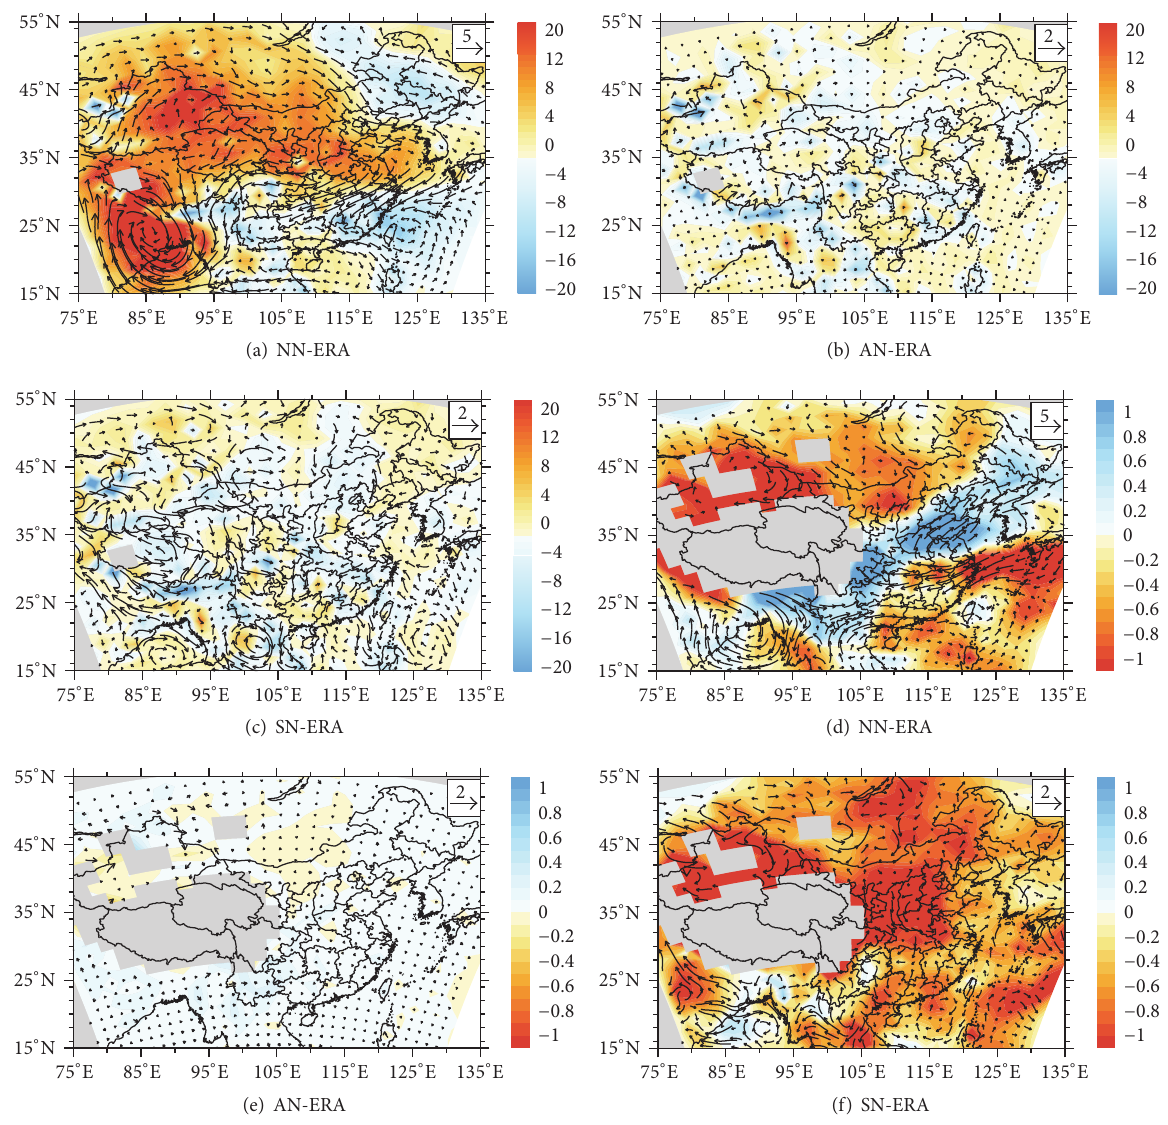
Figure 8: The model biases of monthly mean geopotential height (shading in units of meter) and horizontal winds (vector in units of 5 m/s withNN,but2 m/swithANandSN)at500hPa((a)–(c))andmonthlymeanwatervapormixingratio(shadinginunitsofq/kg)andhorizontal winds at 700 hPa ((d)–(f)) in June, 2011. Respectively, (a) and (d) are the biases simulated with the no nudging experiment (NN), (b) and (e) are the biases simulated with the analysis nudging experiment (AN), and (c) and (f) are the biases simulated with the spectral nudging experiment (SN). All the biases are defined by the departure of WRF simulations from ERA-IN. Gray zones are the missing value masked by the